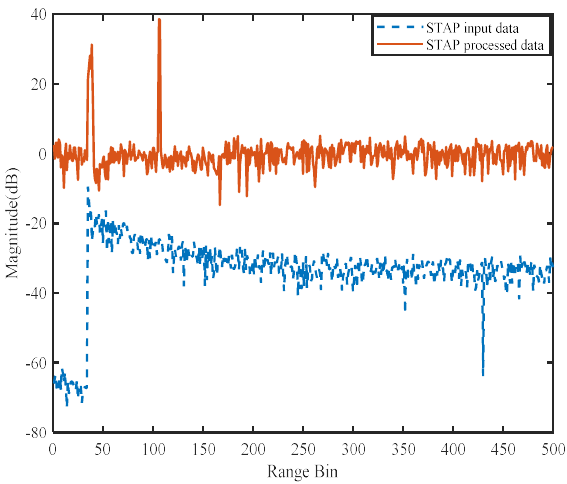
Figure 13. 1D range processed data.